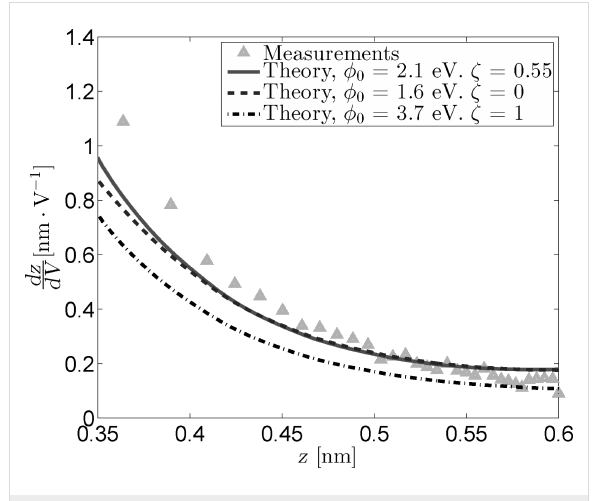
Figure 4: Measured and reconstructed dz / dV traces obtained from z ( V ) measurements by using three sets of fit parameters. As is